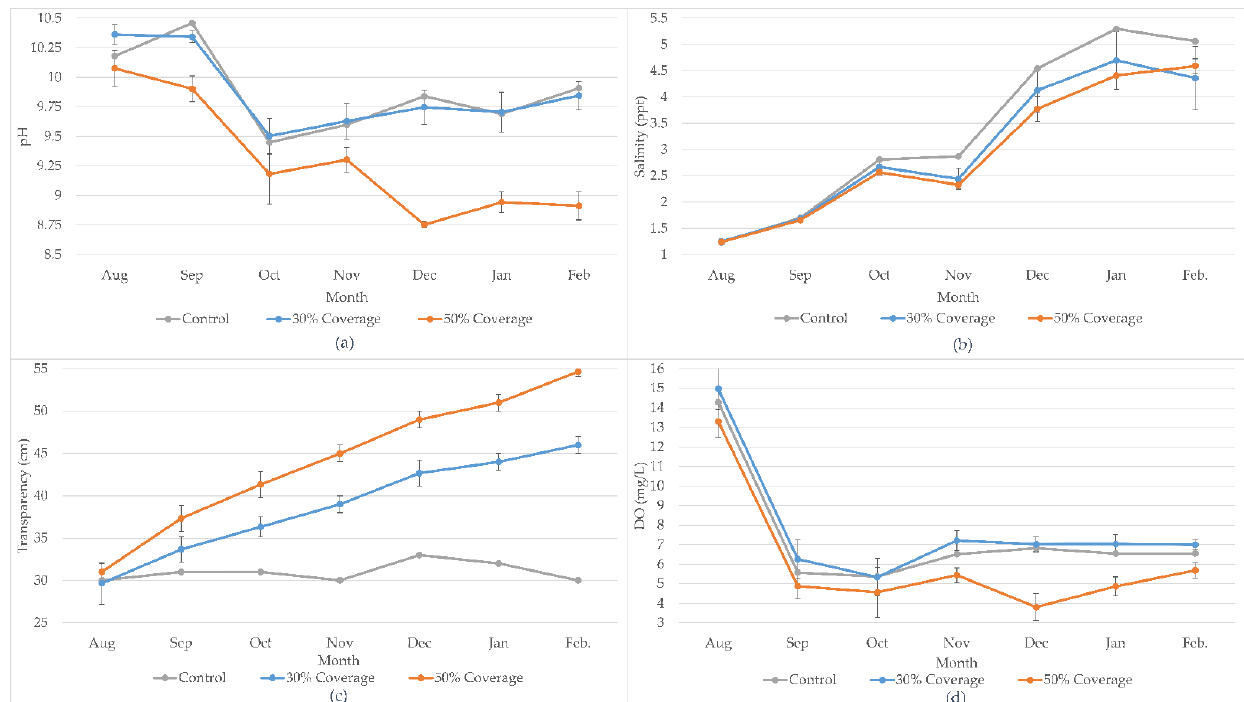
Figure 7. ( a ) pH levels during experimental period. ( b ) Salinity levels during experimental period. ( c ) Variation of water transparency levels during the experimental period. ( d ) Levels of dissolved oxygen during the experimental period.